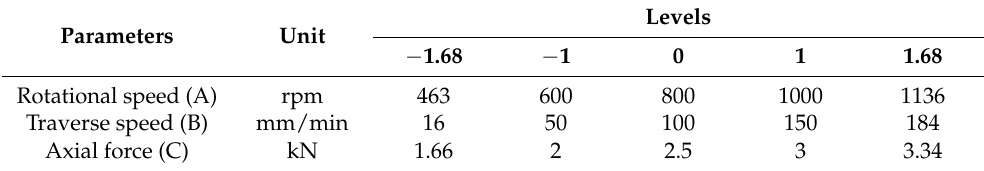
Table 1. The parameters and their levels used in this study, according to the CCRD method.